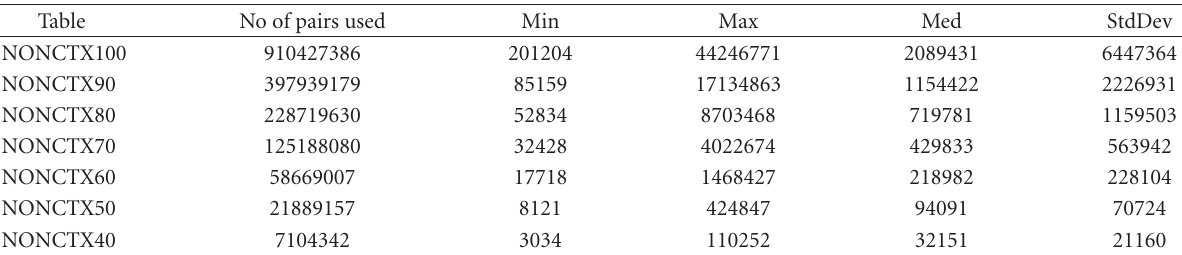
Table 2. The robustness of noncontextual tables. The range, median, and standard deviation for the number of examples drawn on per substitution score. Table